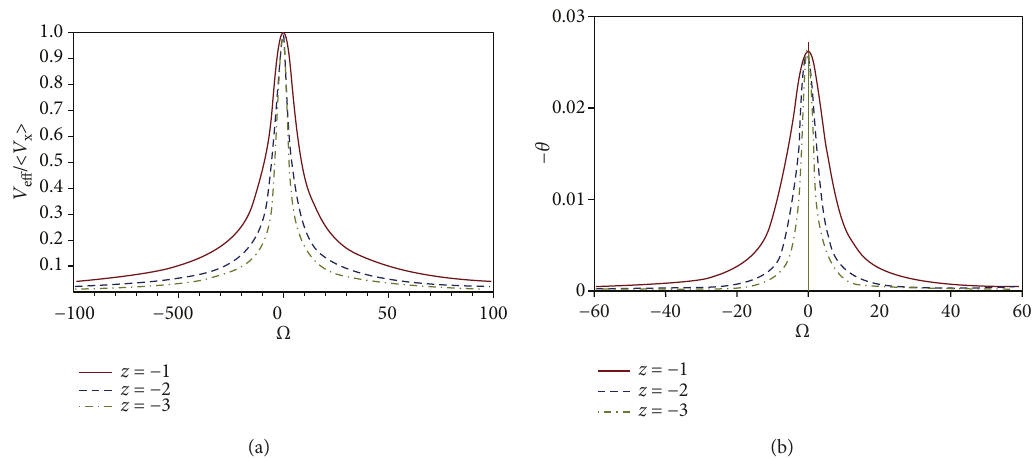
Figure 2: (a) E ff ective velocity as a function of the dimensionless orthogonal fi eld, Ω , for various values of the valence, z . (b) Universal dispersion coe ffi cient plotted against the dimensionless orthogonal fi eld, Ω , and ̂ x = 0 5 , α = 5 , and γ = 0 5 for varying values of valence, z